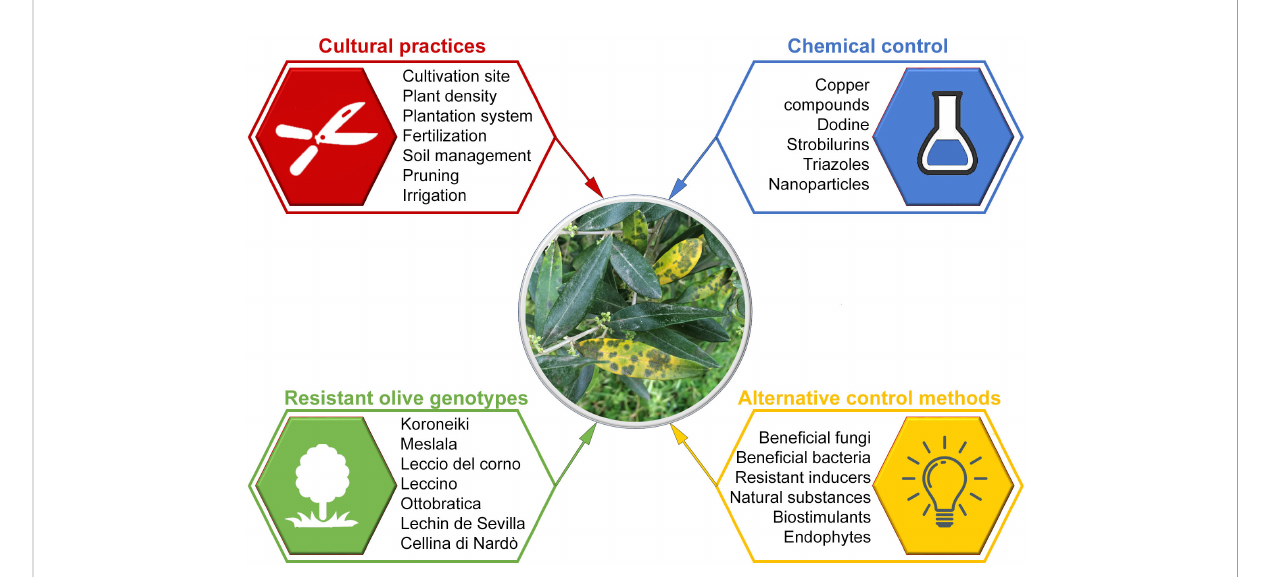
FIGURE 4 Riassuntive scheme on control of olive leaf spot caused by Venturia oleaginea